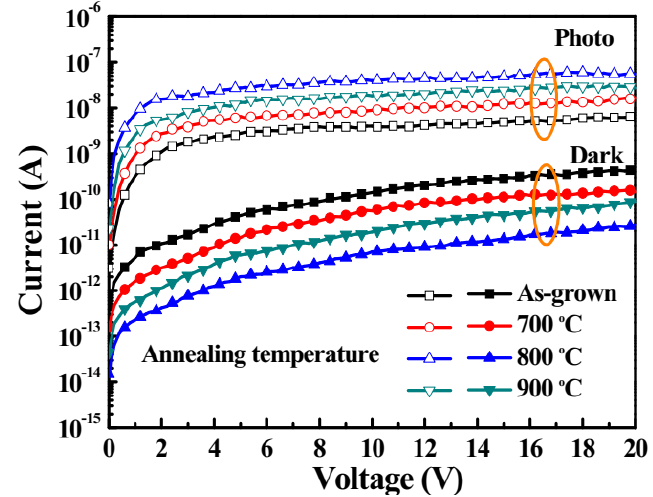
Figure 6. Dark current and photocurrent of various Ga 2 O 3 -based metal-semiconductor-metal ultraviolet C photodetectors (MSM UVC-PDs) as a function of bias